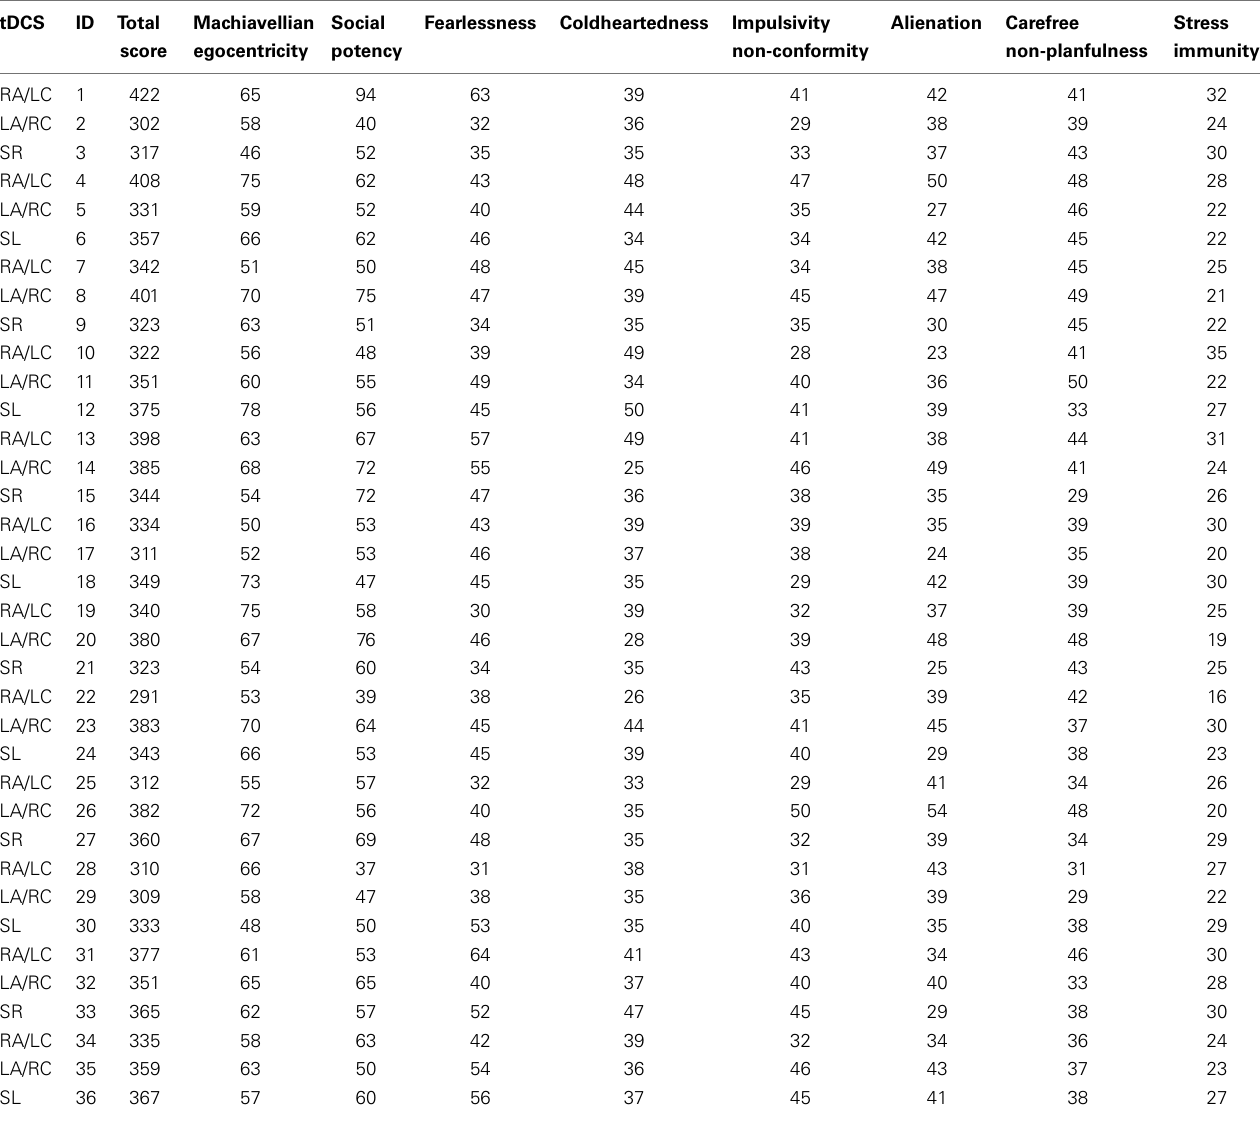
Table 1 | Scores for each participant at the Psychopathic Personality